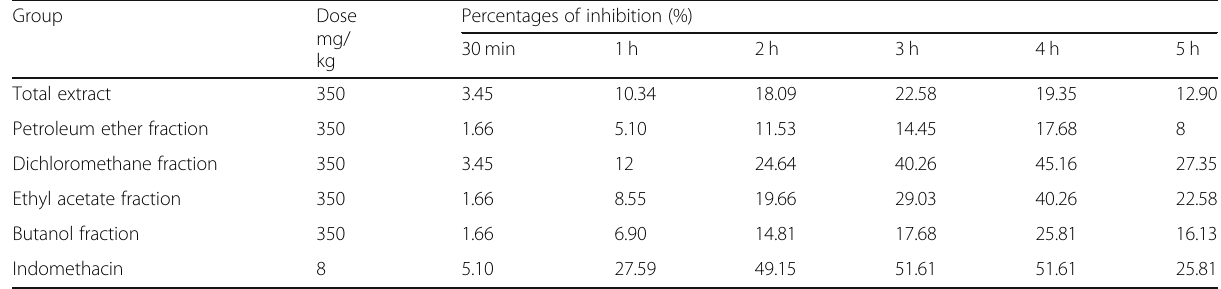
Table 6 Results representing the percentages of edema inhibition of the total ethanol extract and the different fractions of C. myxa L.